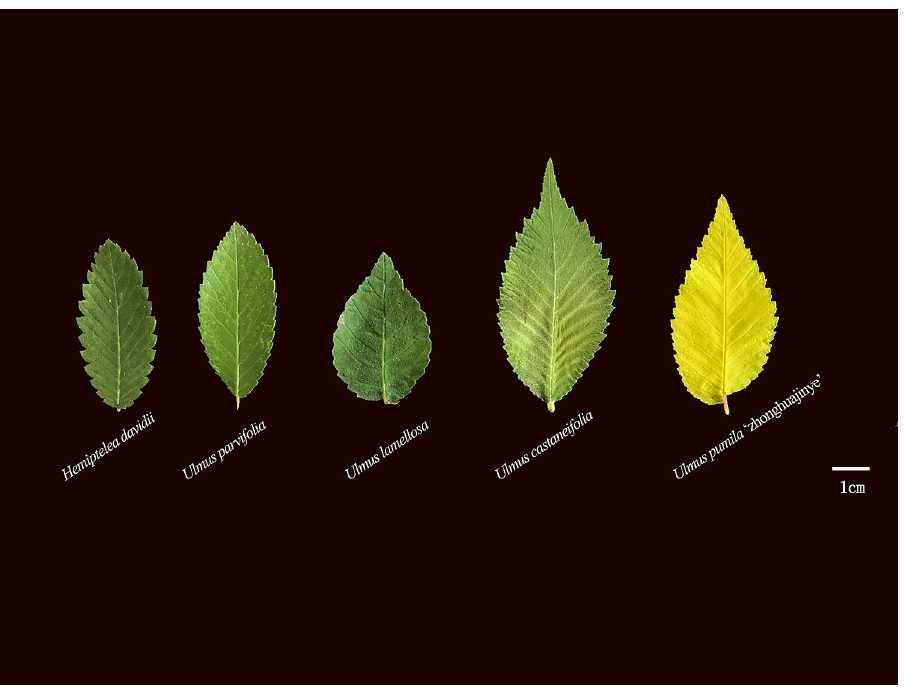
Figure 1. Leaves characteristic of four Ulmus species and H.